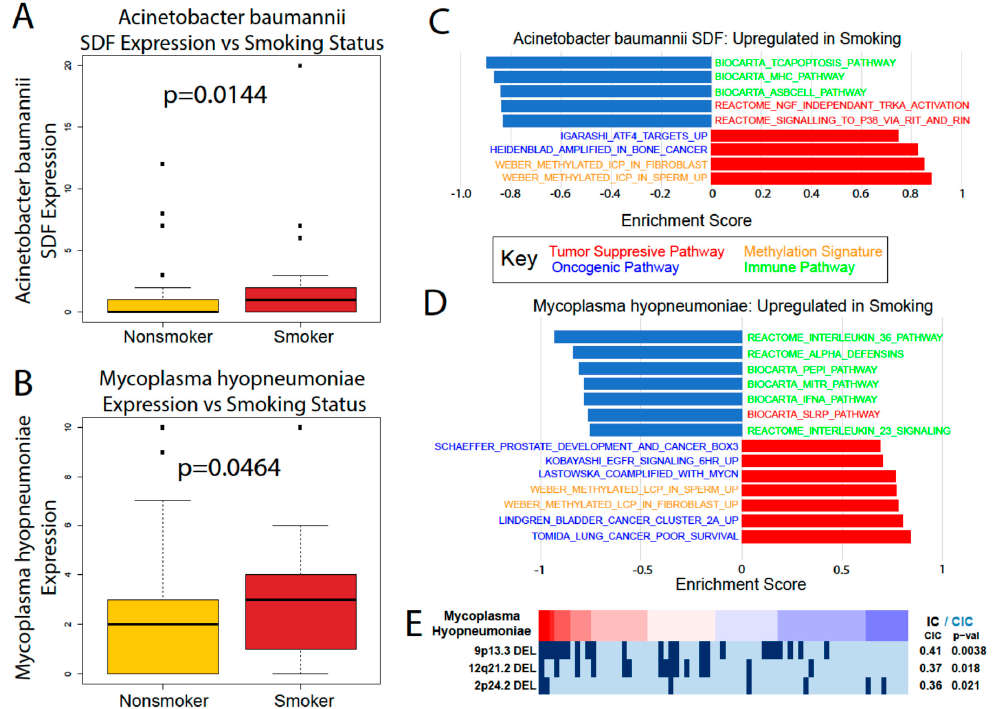
Figure 6. Analysis of the smoking vs. nonsmoking PAAD microbiome. ( A ) A. baumannii and ( B ) M. hyopneumoniae were both upregulated in smokers versus nonsmokers according to the Kruskal–Wallis test ( p < 0.05). GSEA analysis comparing the cancer and immune-associated pathways in smokers to the ( C ) A. baumannii and ( D ) M. hyopneumoniae abundance. ( E ) REVEALER analysis results for M. hyopneumoniae in smoking patients.